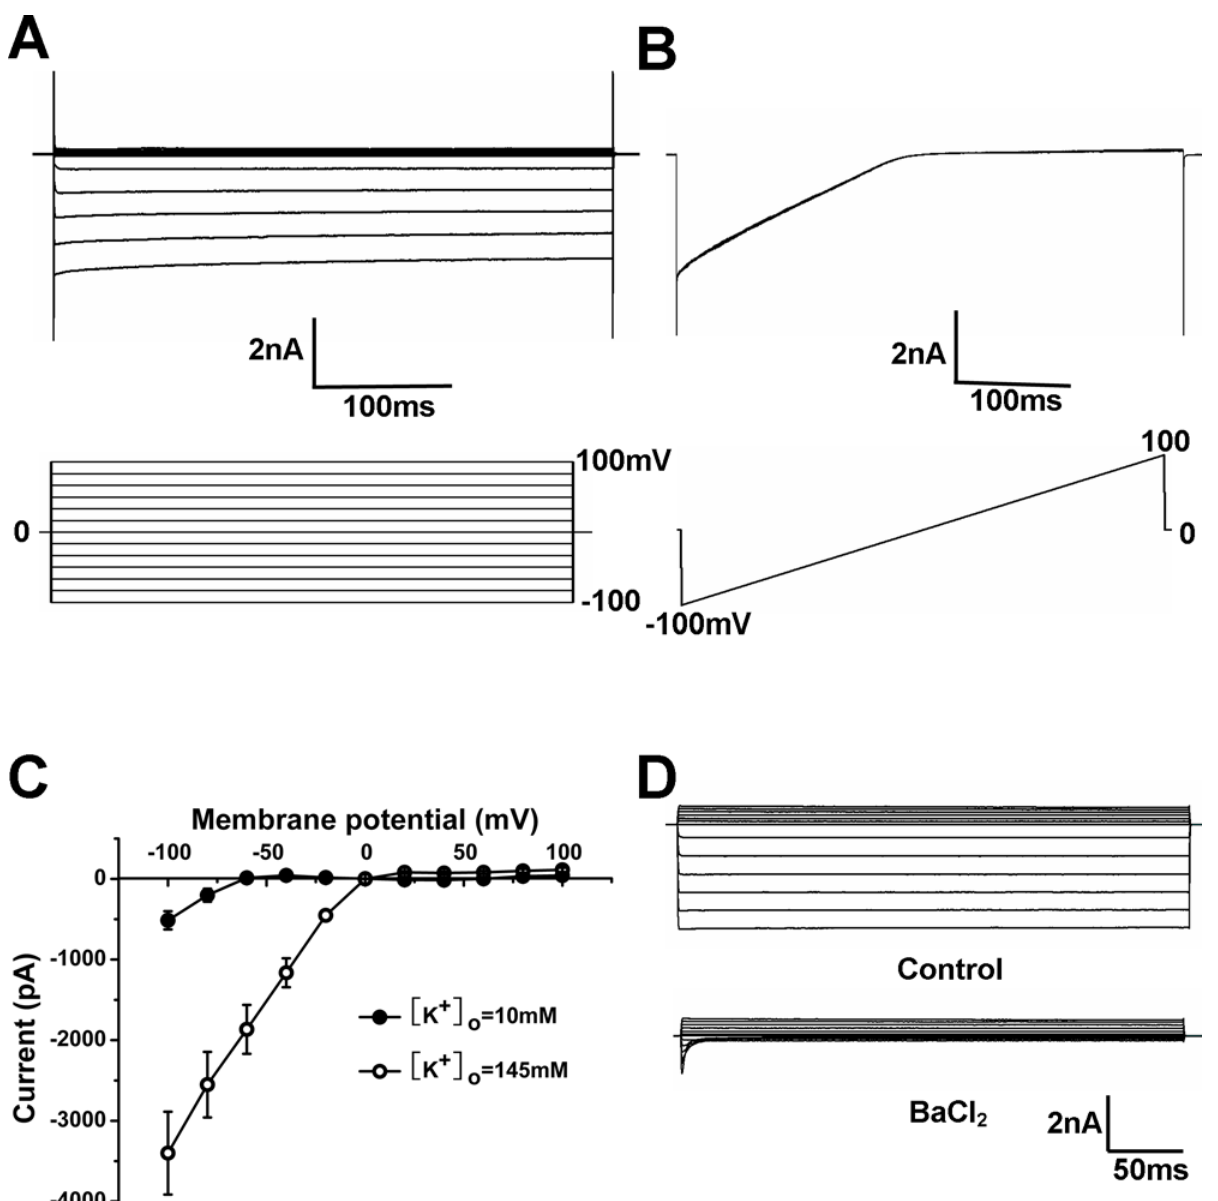
Fig 1. Whole-cell K + currents in cultured PAECs. (A) Representative whole-cell K + currents were recorded in cultured PAECs. The whole cell currents were recorded with a holding potential at 0mV and command pulses from -100 mV to 100 mV. The recording was obtained under symmetrical conditions with bath and pipette solution containing 145mM K + . (B) Current traces obtained with a voltage-ramp command from -100mV to 100 mV and the reverse potential was near to 0 mV under symmetrical condition with bath and pipette solutions indicated in (A). (C) Current-voltage relationships were obtained from symmetrical condition indicated in (A) and replacing bath solution for 10 mM K + . The inwardly rectifying component was obviously reduced if the extracellular K + concentration is decreased from 145 to 10 mM, and the reversal potential was shifted to – 66 ± 1 mV. (D) Exposure of the cells to Ba 2+ led to a strong inhibition of these K + currents in the inward direction with very little effect on the outward